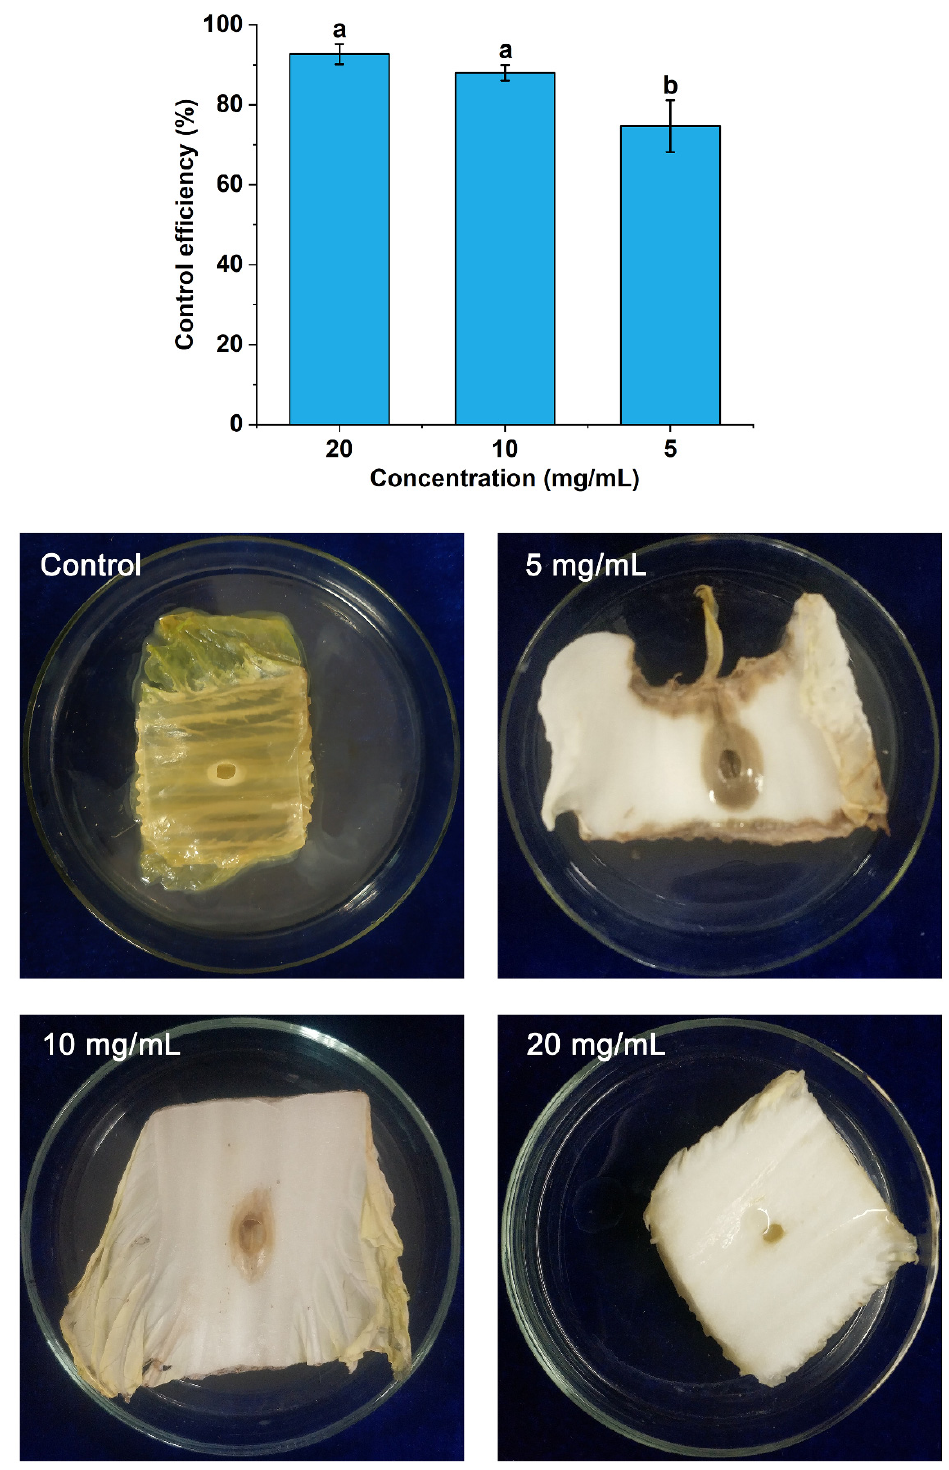
Figure 4. Protective activity of Polygonum orientale essential oil against Pectobacterium carotovorum subsp. carotovorum . The control was treated with 3% DMSO and 1% Tween 20. A significant difference was expressed ( p < 0.05).